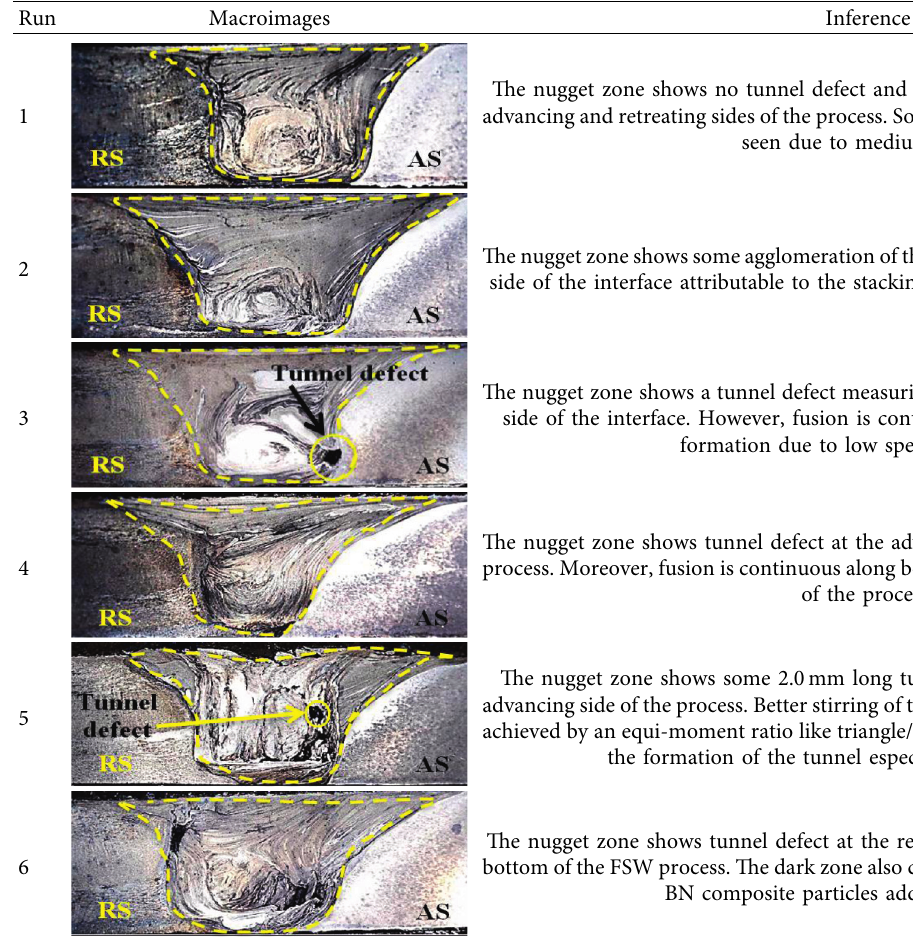
Table 6: Macrographs of the FSW composite